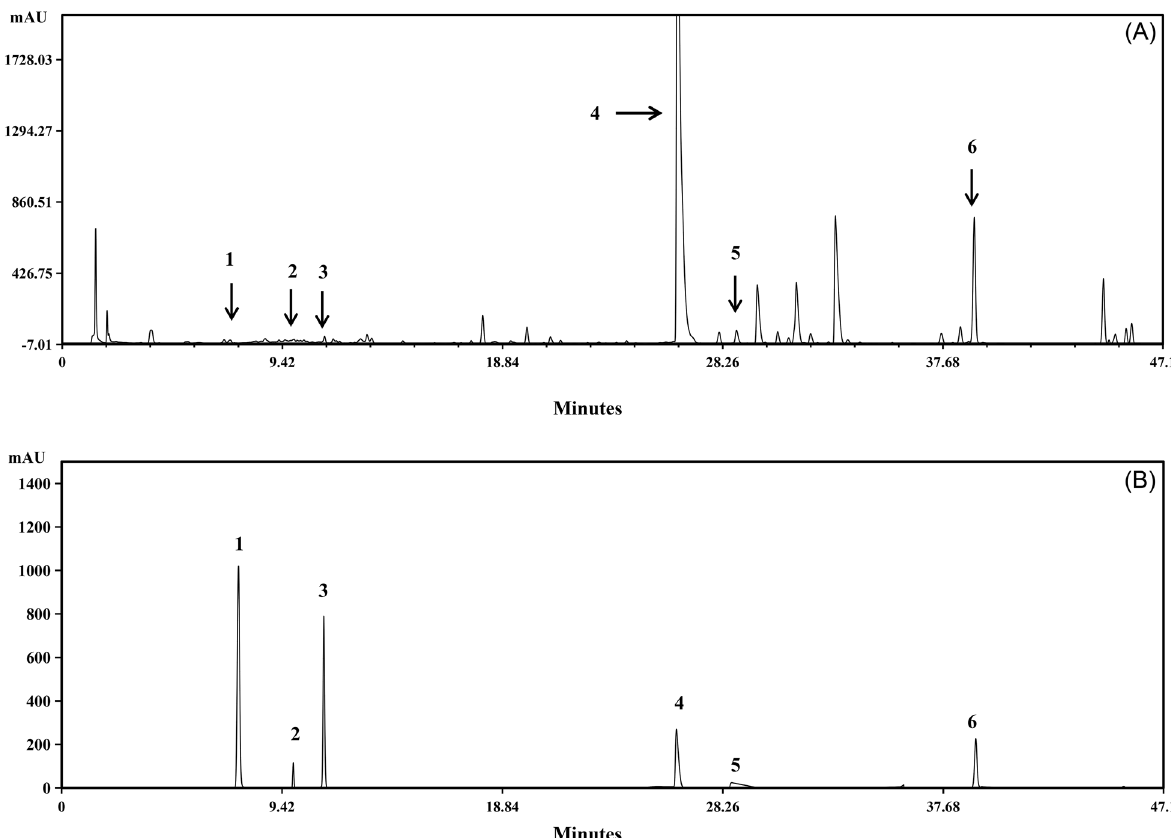
Figure 1. The traditional Chinese medicine system of evaluating fingerprint similarity was used to create a representative Ultra-Performance Liquid Chromatography chromatogram of Pudilan at 289 nm ( A ) and the reference chromatogram ( B ). The six main peaks were represented by the peaks numbered 1–6 in the chromatogram. The peaks denoted by the numbers 1, 2, 3, 4, 5 and 6 were, respectively, epigoitrin, chlorogenic acid, caffeic acid, baicalin, acetylcorynoline and baicalein.